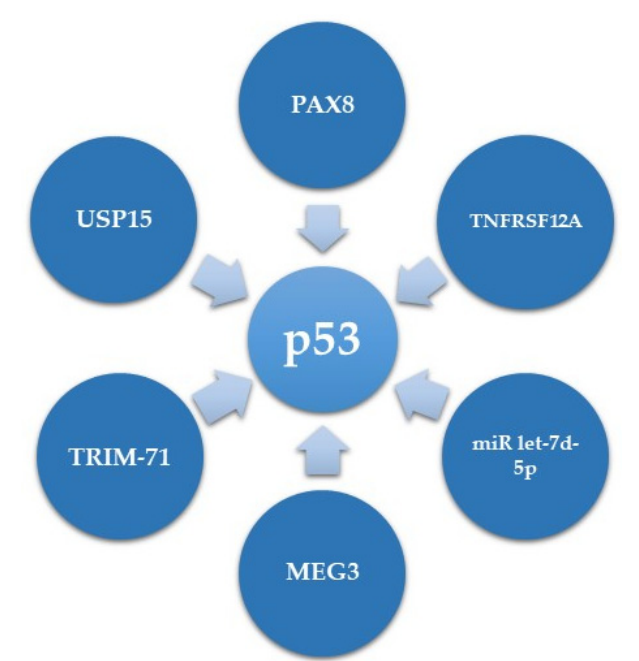
Figure 2. Upstream regulators of p53.